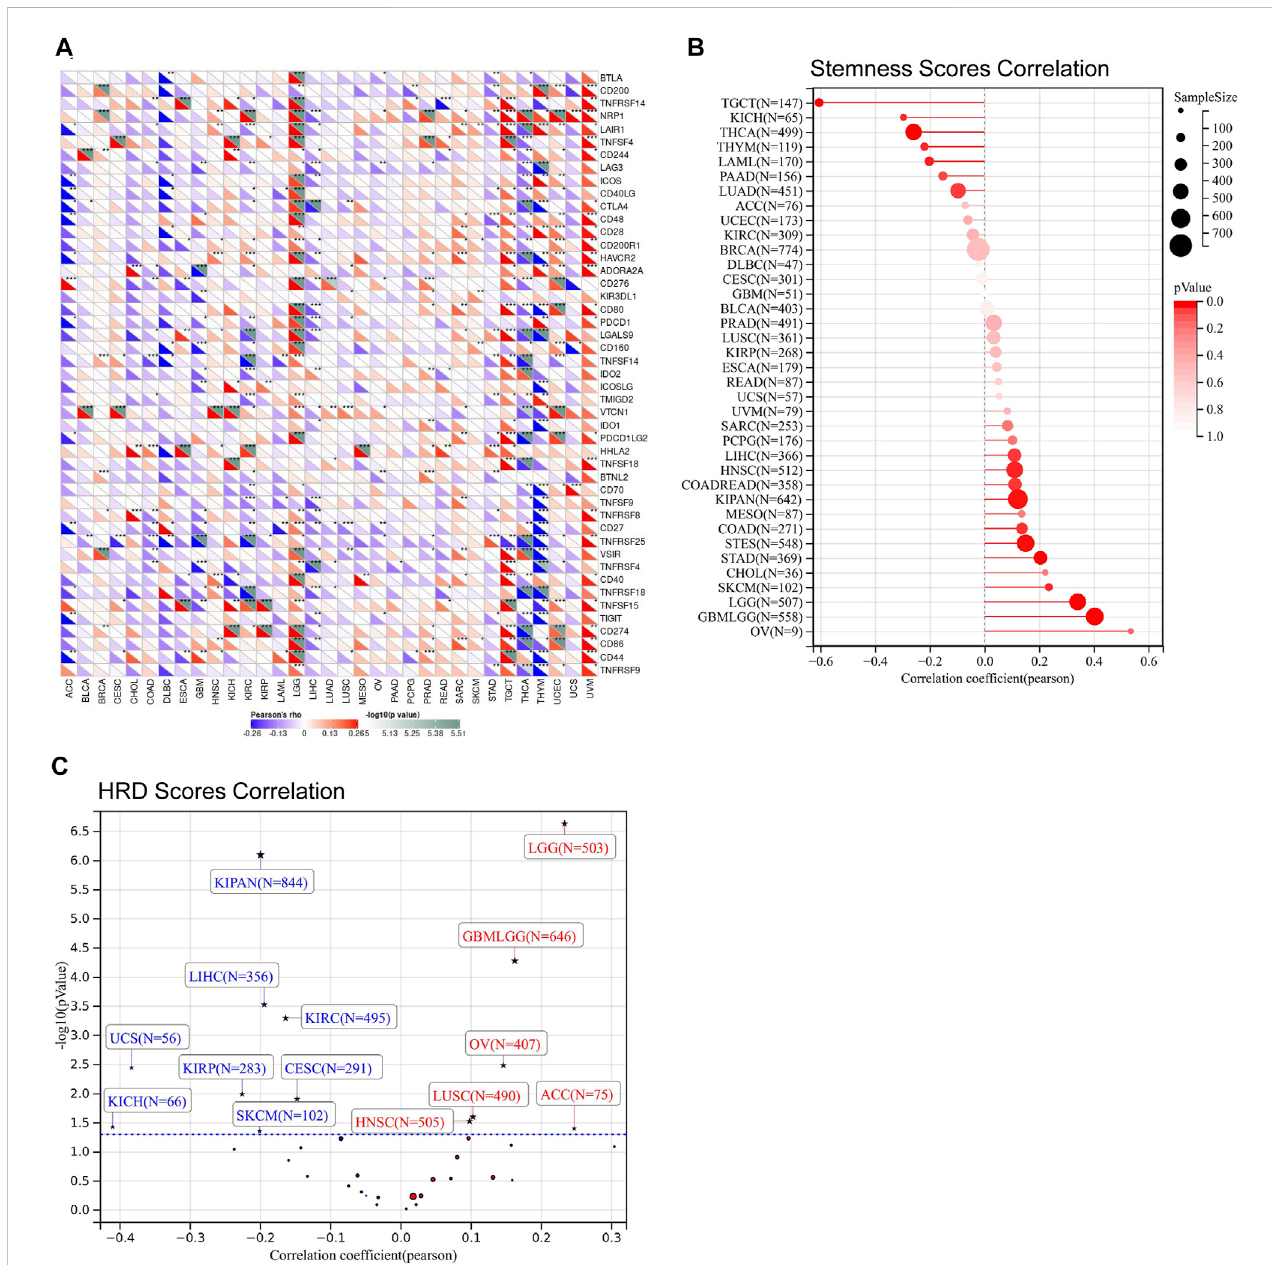
FIGURE 5 The relationship between FDX1 expression and immune checkpoints, stemness scores obtained from DNA methylation data, and homologous recombinationde fi ciency(HRD). (A) Correlationbetween FDX1expression andimmunecheckpoints. (B) Correlation between FDX1expression andstemness scores. (C) CorrelationbetweenFDX1expressionandHRD[PositivecorrelationtumortypeincludingGBMLGG(N=646,R=0.16, p =0.00005),LGG(N=503, R = 0.23, p = 2.30e-7), HNSC (N = 505) (R = 0.10, p = 0.03), LUSC (N = 490, R = 0.10, p = 0.02), OV (N = 406, R = 0.13, p = 0.008), ACC (N = 75, R = 0.25, p =0.03)andNegativecorrelationtumortypeincludingCESC(N=291,R= − 0.15, p =0.01),KIRP(N=283,R= − 0.23, p =0.01),KIPAN(N=844,R= − 0.20, p = 7.85e-7),KIRC(N=495,R= − 0.16, p =0.0005),LIHC(N=356,R= − 0.19, p =0.0002),SKCM(N=102,R= − 0.20, p =0.04),UCS(N=56,R= − 0.38, p =0.005), KICH(N=66,R= − 0.41, p =0.04)].(AllcorrelationanalysiswasshownbyPearsoncoef fi cient, p < 0.05wasconsideredsigni fi cant,* p < 0.05,** p < 0.01,*** p <